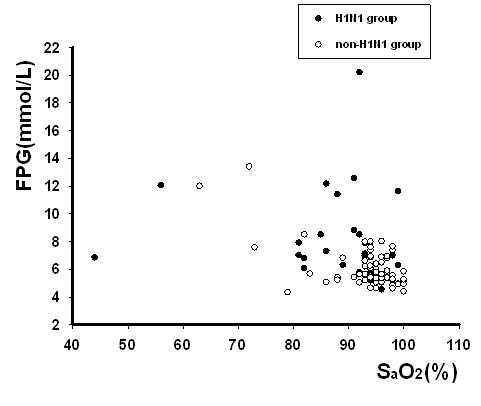
The relationship between FPG and SaO2 among H1N1 and non-H1N1 group evaluated by scatter graph.